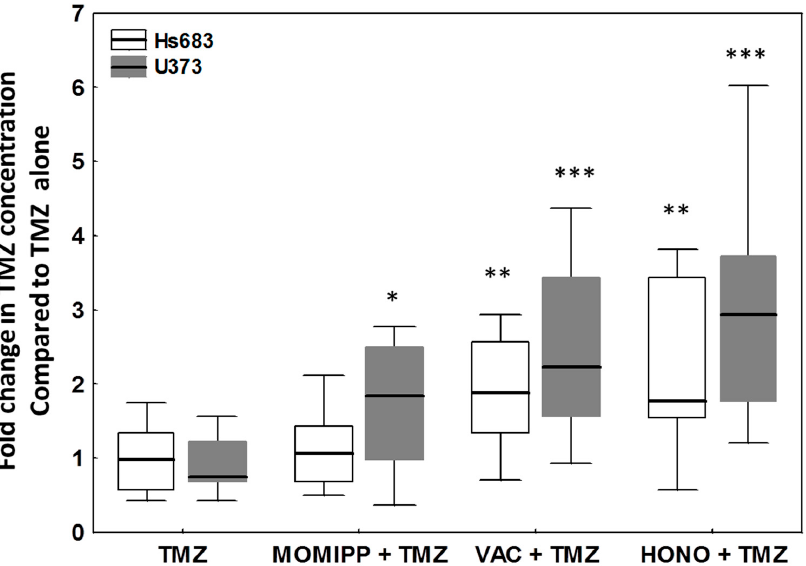
Figure 9. Temozolomide (TMZ) concentrations in U373 and Hs683 cell lysates after two hours of treatment with TMZ (200 µ M). Cells were pre-treated with honokiol for 22 h (HONO + TMZ), vacquinol-1 for 15 h (VAC + TMZ) or MOMIPP for 3 h (MOMIPP + TMZ). Data are expressed as fold-change TMZ concentrations compared to its own control (TMZ alone) by box plots: line, median fold change; boxes, percentiles 25–75; whiskers, non-outlier ranges of 12 replicates. TMZ concentration of the cells treated with TMZ alone was normalized to 1. Statistical comparison has been made by the Mann–Whitney test. p < 0.05 (*), p < 0.01 (**) and p < 0.001